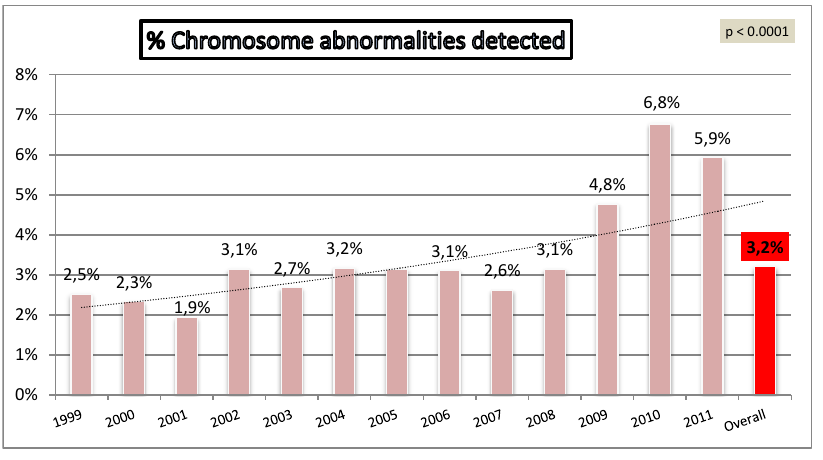
Figure 4. Annual detection of chromosome abnormalities.